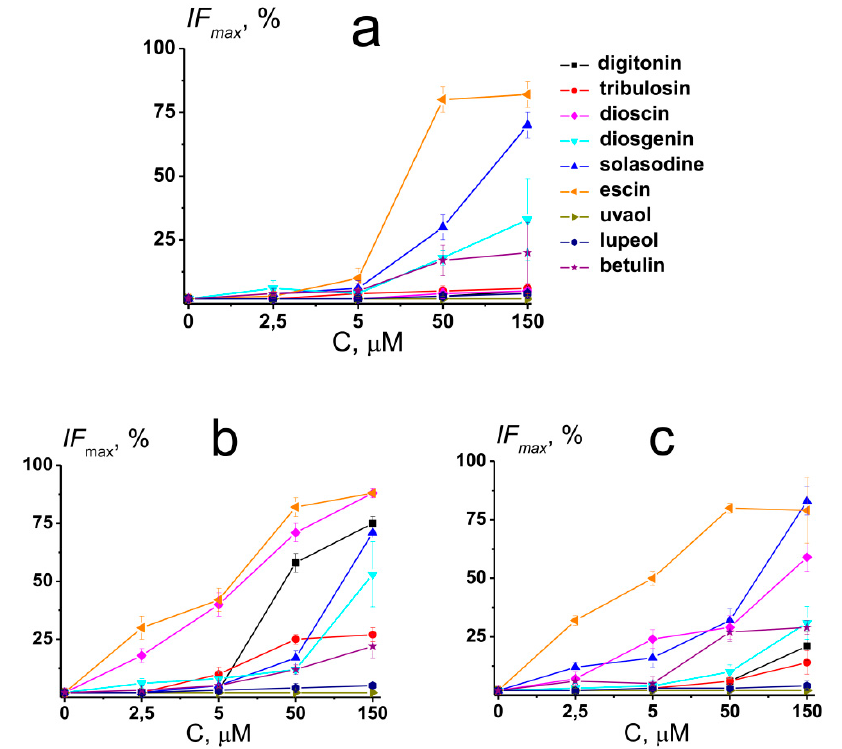
Figure 5. The dependence of relative fluorescence of calcein ( IF max ,%) leaked from POPC ( a ), POPC/CHOL ( b ), and POPG ( c ) vesicles on the concentration of different saponins and related compounds. The relationship between the color line and the compound is given on the figure.